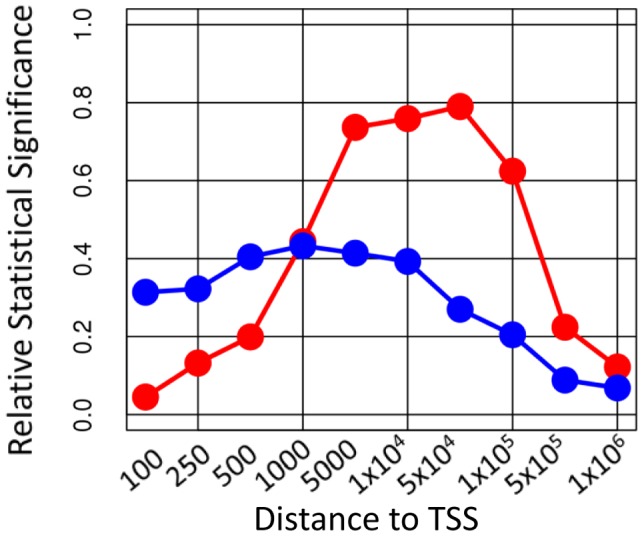
Relative statistical significance of the association between ChIP-seq and differential gene expression data for different window sizes.The ratio of −log10(p-value of enrichment) of differentially expressed genes (FDR<0.1) among genes with high MPI scores, and −log10(p-value of enrichment) of differentially expressed genes among genes with high TREG binding scores. The ratios related to E2f1 ChIP-seq data and E2 differential gene expression profile are represented by the blue line. The ratios related to ERα ChIP-seq data and are represented by the red line. Ratios smaller than 1 indicate higher significance of enrichment when using TREG scores, as opposed to maximum peak height within the given window.